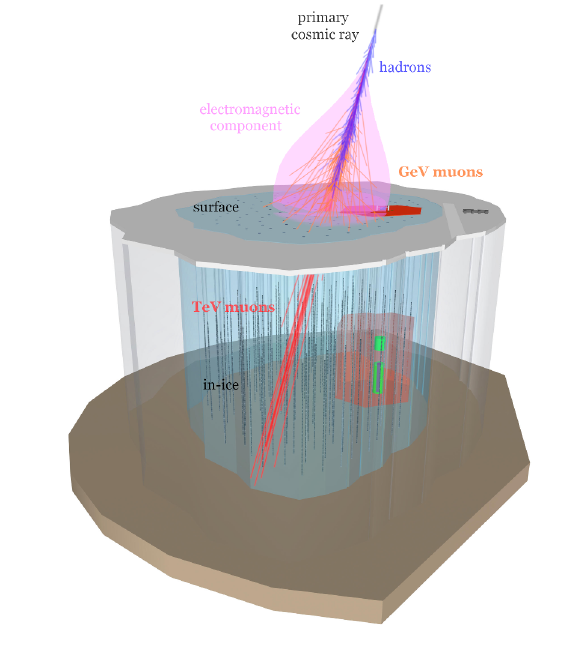
Figure 3. IceCube-Gen2, though optimized for neutrino as- tronomy, will also be a unique lab to study particle physics in air-showers because a surface measurement of the electromag- netic component and low-energy muons is combined with a high- energy muon measurement in the ice. Compared to the cur- rent IceCube detector with its surface array IceTop (in red), the larger IceCube-Gen2 detector (light blue) will measure surface- deep coincidences for a wider range of zenith angles. Together with the larger surface area, this will result in an overall 30x in- crease of aperture for such surface-deep coincident events. [Fig- ure courtesy of the IceCube-Gen2 collaboration